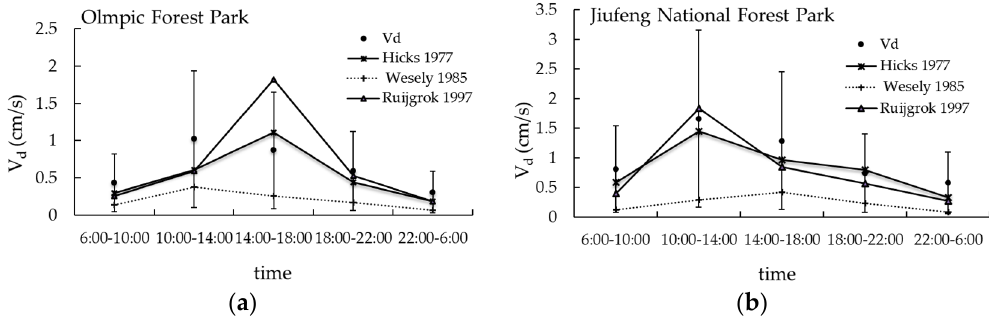
Figure 5. The daily variation of measured V d and calculated V d by using different parameters. ( a ) Olympic Forest Park; ( b ) Jiufeng National Forest Park.